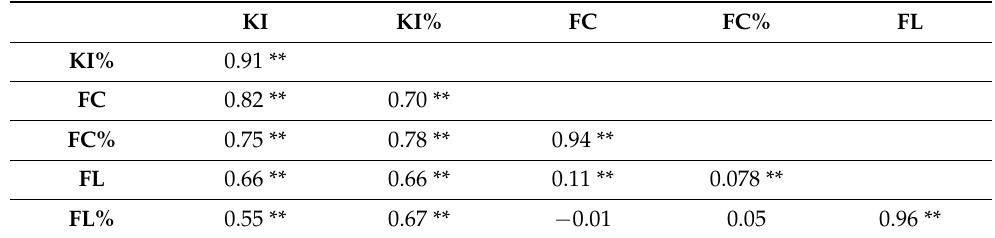
Table 1. Correlation coefficients between postural parameters. KI KI% FC FC% FL KI% 0.91 ** FC 0.82 ** 0.70 ** FC% 0.75 ** 0.78 ** 0.94 ** FL 0.66 ** 0.66 ** 0.11 ** 0.078 ** FL% 0.55 ** 0.67 ** − 0.01 0.05 0.96